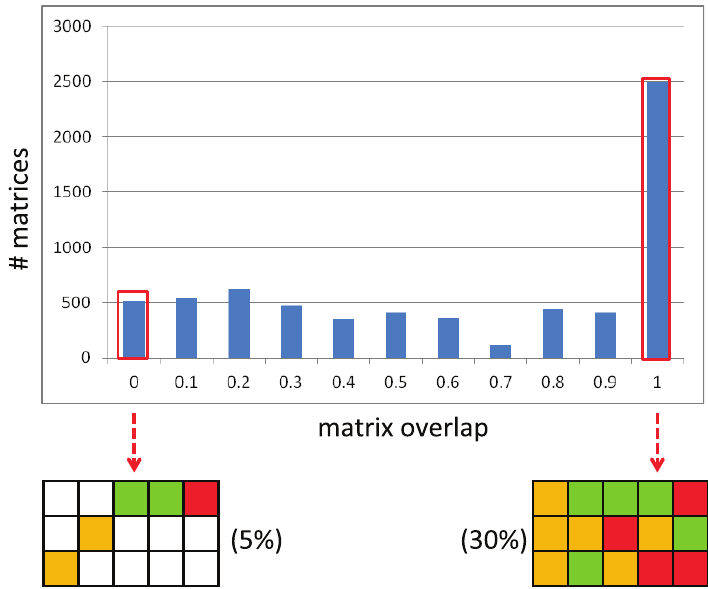
Figure 3. Matrix overlap distribution. Shown is a histogram with the matrix overlap distribution for SARMs from an in-house focused